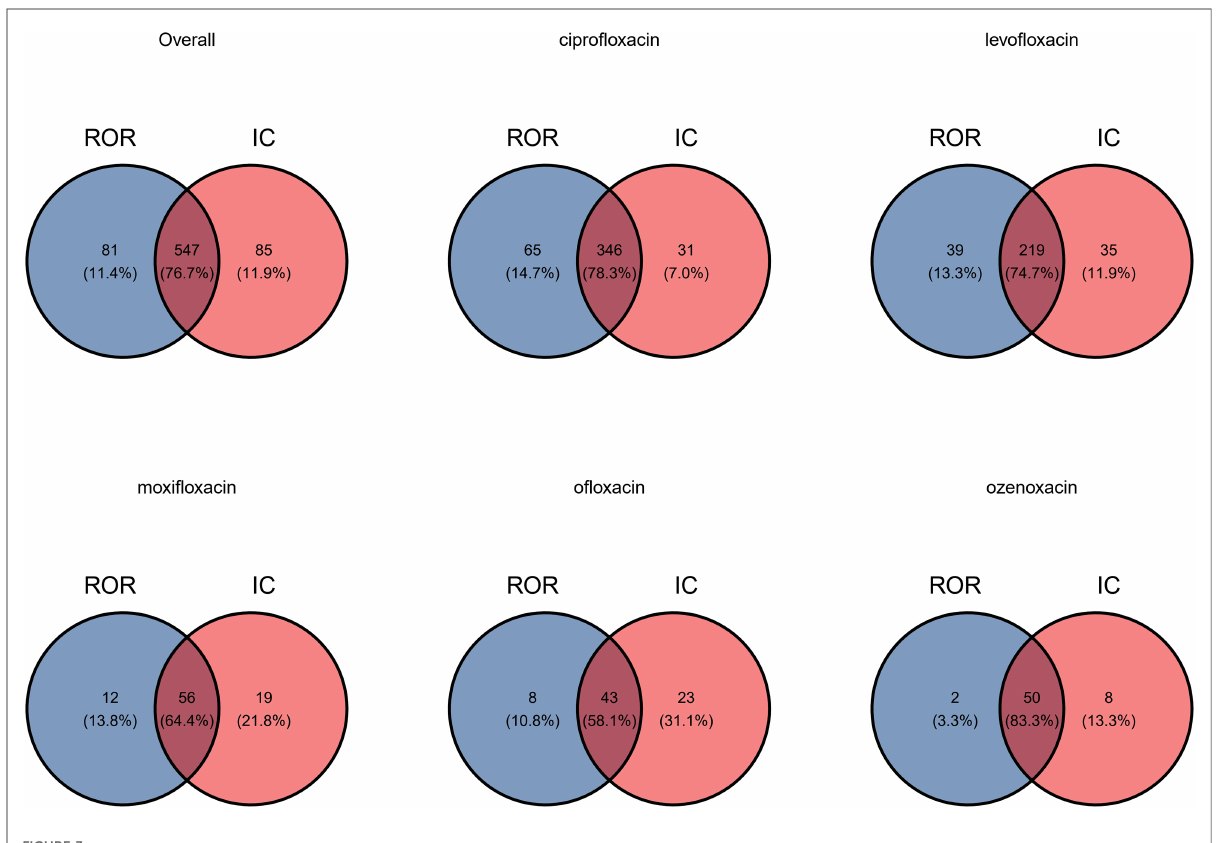
FIGURE 3 The Venn diagram for signals of AE reports of